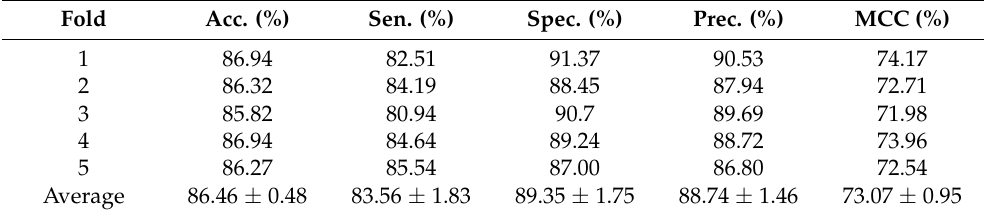
Table 2. The performance of the proposed method in ncDR datasets.